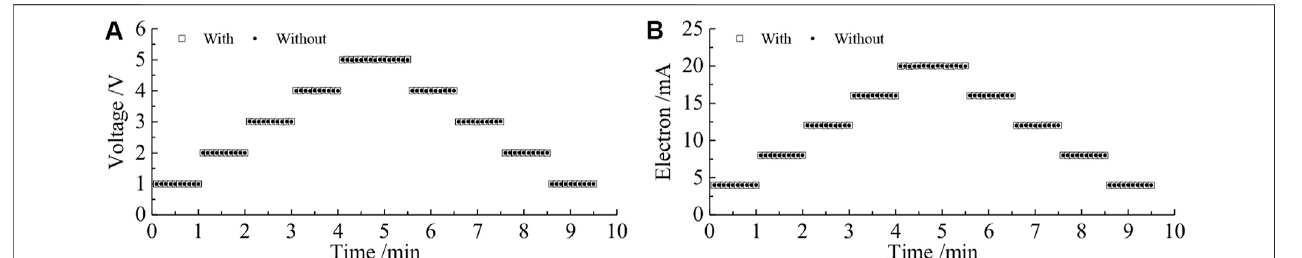
FIGURE 6 | Comparison of (A) voltage and (B) electron signals with or without a multi-channel selector.